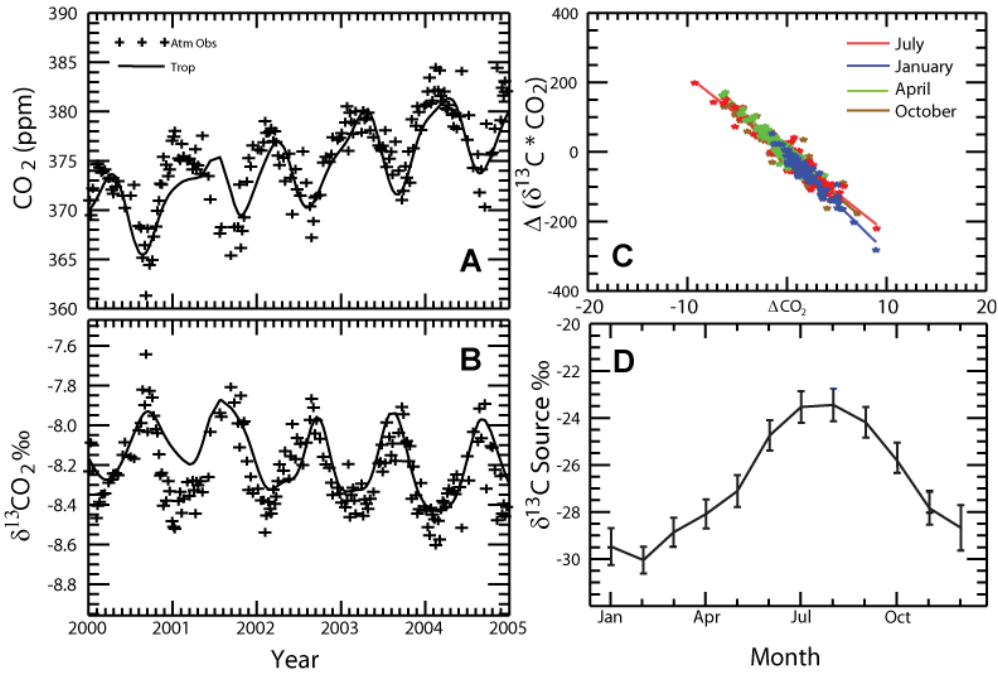
Figure 1. Analytical approach to inferring δ 13 CO 2 source to the atmosphere. Panel A shows the seasonal cycle of atmospheric CO 2 observations at Wendover, Utah (UTA) compared with free troposphere observations of CO 2 at Niwot Ridge, Colorado (NWR). Panel B shows atmospheric δ 13 CO 2 observations at UTA compared to free troposphere observations of δ 13 CO 2 at NWR. Panel C shows the residual technique used for inferring changes in δ 13 CO 2 source (δ s ) to the atmosphere, where δ s is estimated as the slope. Lastly, Panel D shows the resultant seasonal pattern in δ s generated from monthly estimates and their associated uncertainties (1 σ).